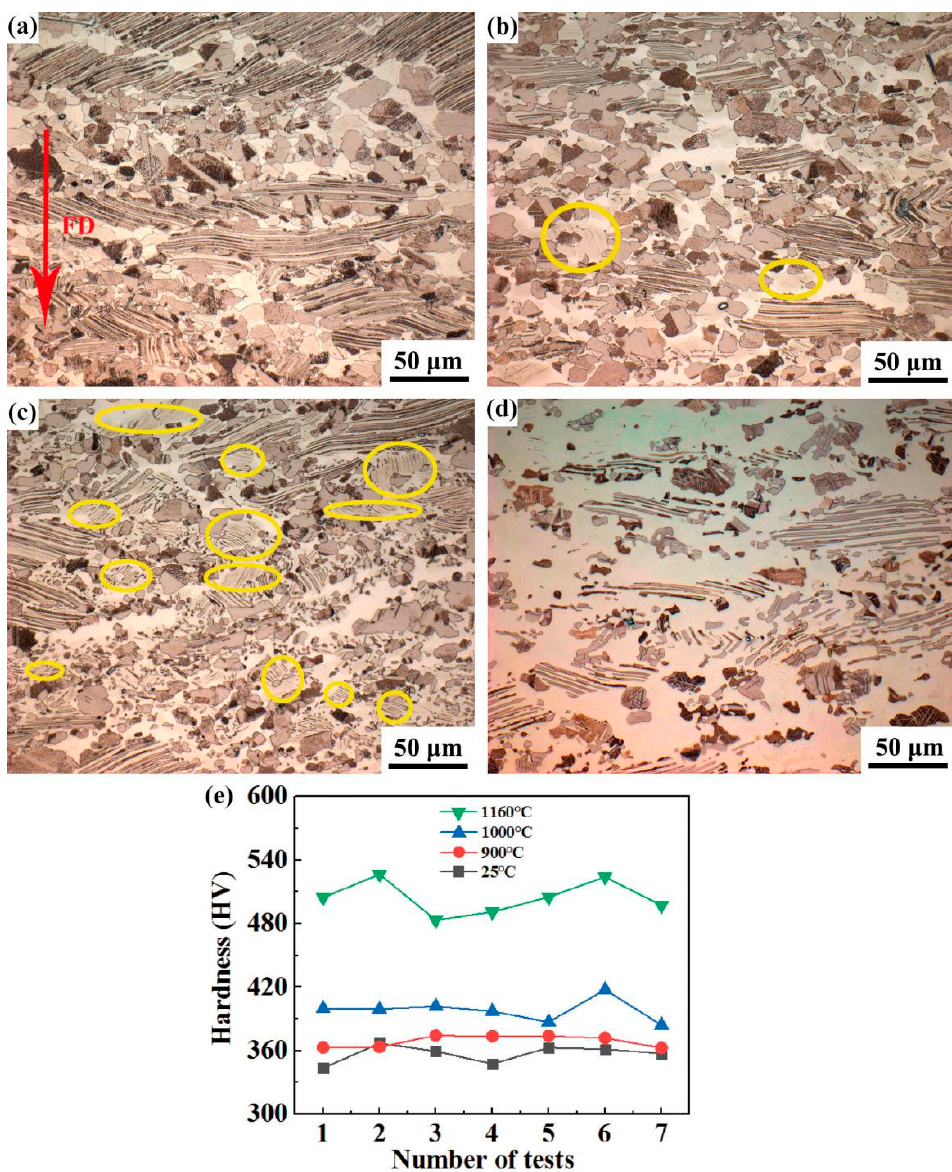
Figure 2. Microstructure of isothermally forged TiAl samples in different states: ( a ) forged sample; ( b ) heating at 900 ◦ C for 6 h; ( c ) heating at 1000 ◦ C for 1 h; ( d ) heating at 1160 ◦ C for 1 h. The last-step isothermal forging direction (FD) is marked ( a ); ( e ) the hardness of the forged samples in various conditions corresponding to samples ( a – d ).